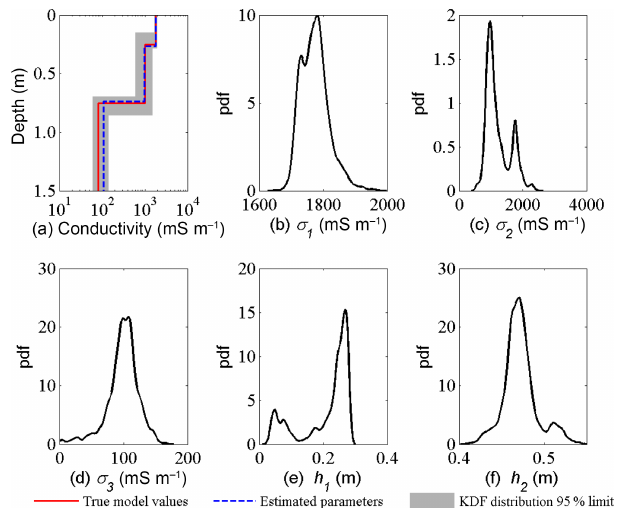
Figure 4. Summary of the MCMC simulation for the synthetic three-layer earth model of saline soil. (a) True (red line) and es- timated parameter (blue dashed line) for the vertical electrical con- ductivity profile, and the gray background with the 95% confidence interval of kernel distribution estimation (KDE). Panels (b–f) show the KDE of the marginalized posterior distributions for the three layer conductivities ( σ 1 , σ 2 , and σ 3 ) and the two layer thicknesses ( h 1 and h 2